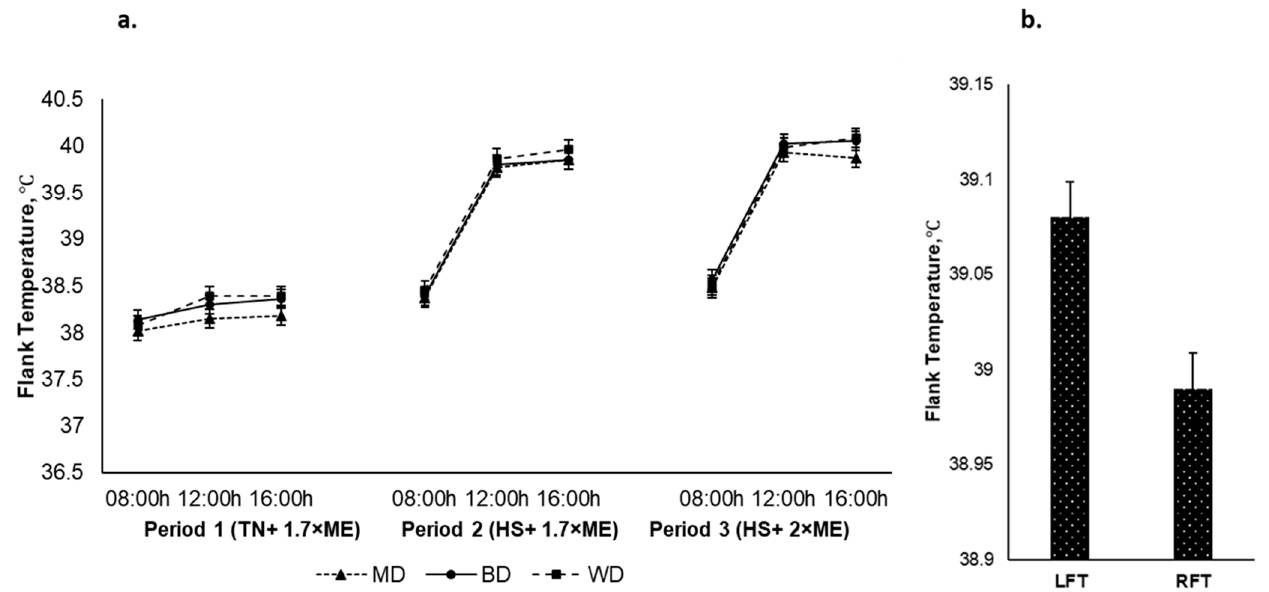
Figure 6. ( a ). Relationship between flank temperature, time of observation, and experimental period in sheep fed on different diets. The standard error of the difference for the interaction between period and dietary treatments and time is displayed on graphs 6. ( b ). Left and right flank temperatures during the experiment. The standard error of the difference for the interaction between period and dietary treatments and time is displayed on the graph. The p -values for the effects of diet, period, time, diet * period, diet * time, period * time, and diet * period * time were and p = 0.398, p < 0.001, p < 0.001, p = 0.118, p = 0. 360, p < 0.001, and p = 0.857.